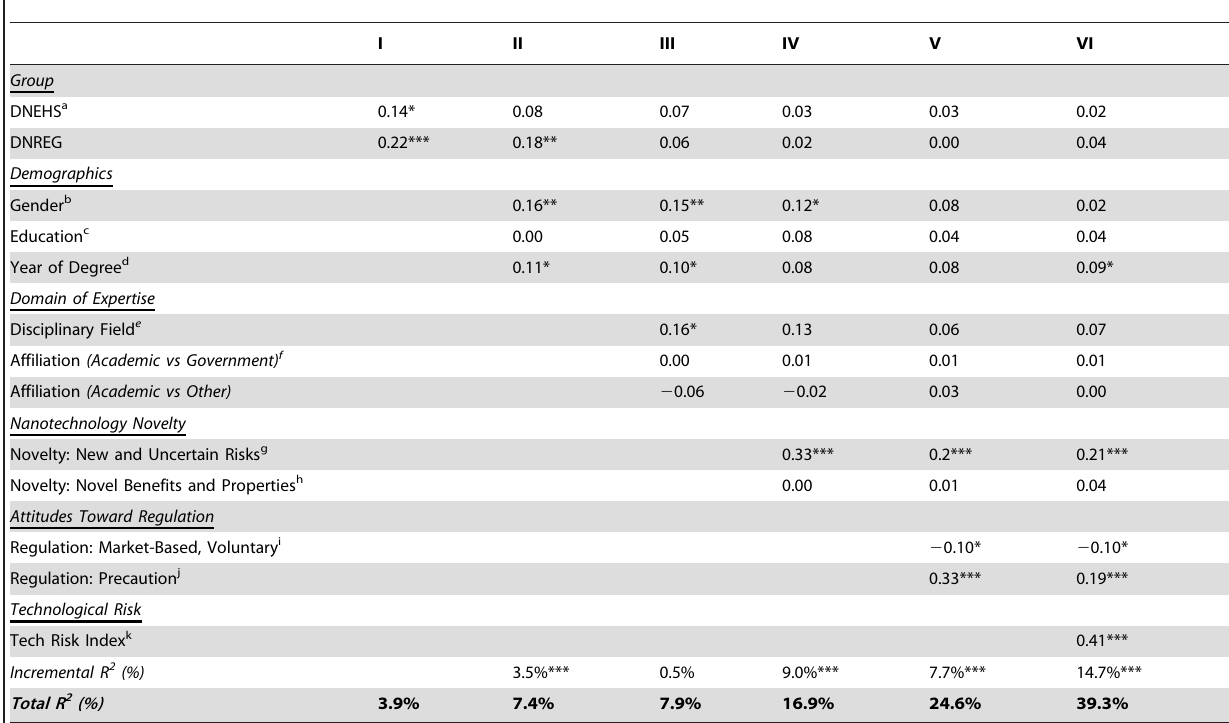
Table 4. Hierarchical regression with Nano Risk Index as dependent